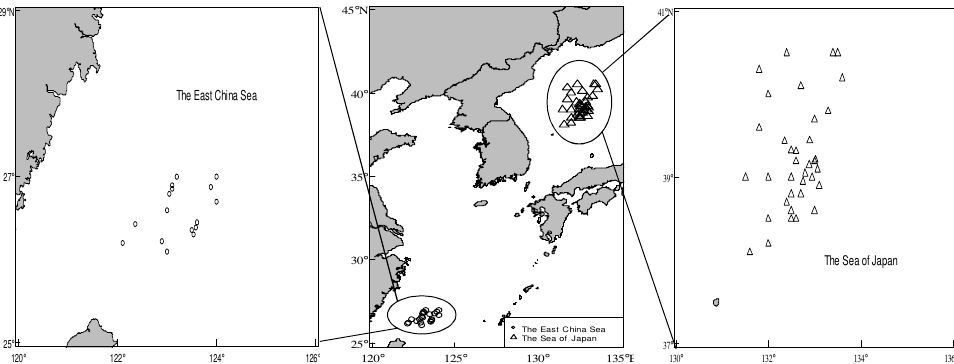
Figure 1. Distribution of sampling stations. (The circles represent sampling stations of T. pacificus in the East China Sea, the triangles represent sampling stations of T. pacificus in the Sea of Japan.)